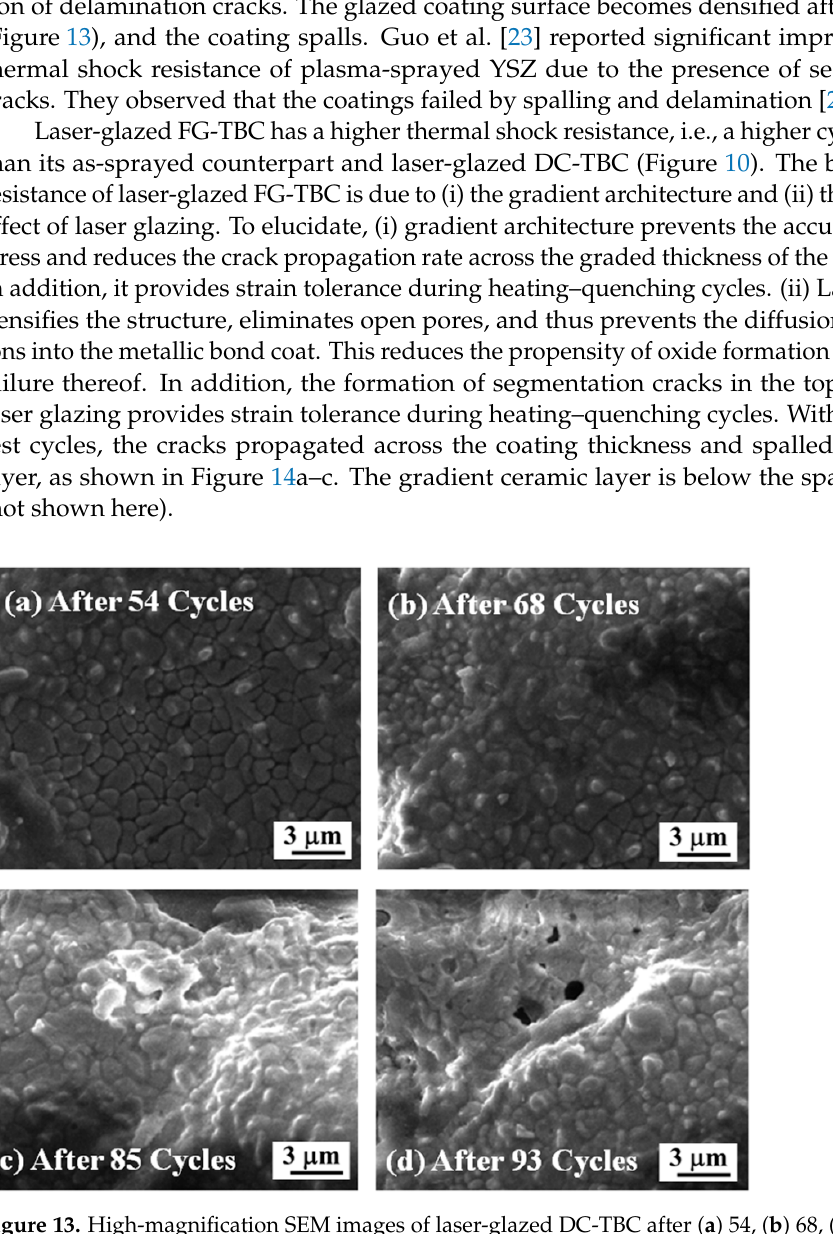
Figure 13. High-magnification SEM images of laser-glazed DC-TBC after ( a ) 54, ( b ) 68, ( c ) 85, and ( d ) 93 heating–quenching cycles.